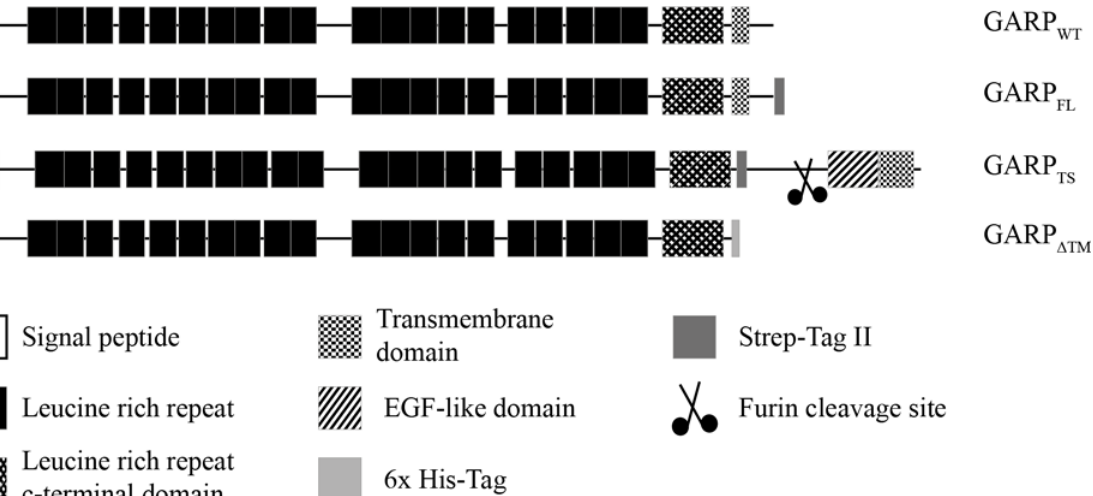
Fig 1. Domain structure of GARP and its recombinant variants. Schematic representation of human GARP and its recombinant variants used in this study. GARP consists of a signal peptide, 20 leucine rich repeats, a leucine rich repeat C-terminal flanking domain and a transmembrane region. For the construct GARP FL a Strep-tag was added at the intracellular C-terminus. Instead of the original GARP transmembrane region, the construct GARP TS possesses the transmembrane region of the protease meprin α and additionally its extracellular EGF-like and inserted domain. This construct was cleaved by furin in the trans-Golgi network and secreted into the extracellular space. For purification and detection a Strep-tag was inserted between the extracellular part of GARP and the meprin α part and a His-tag between the signal peptide and the mature chain. GARP Δ TM lacks the complete transmembrane region of GARP, but contains a His-tag instead at the C-terminus of the extracellular part.